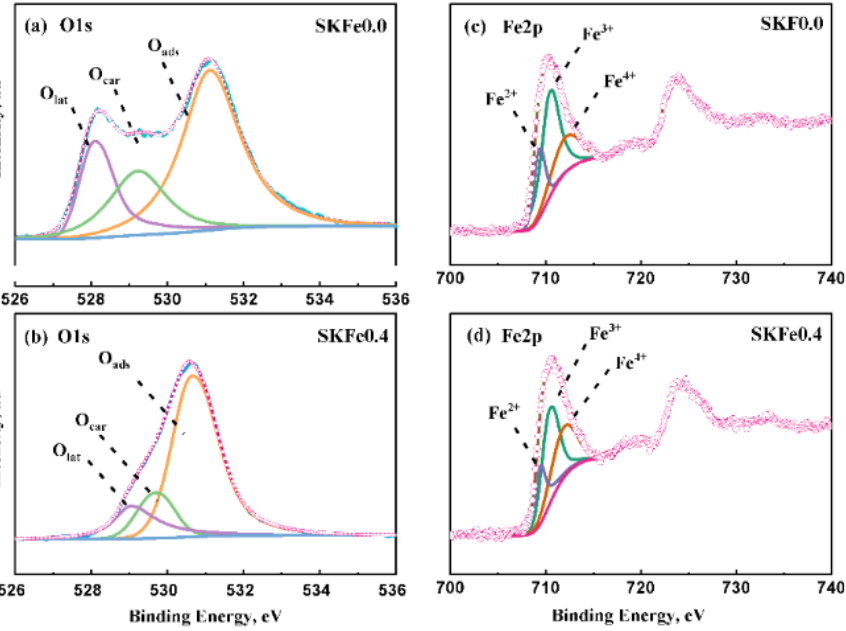
Figure 9. O 1s and Fe 2p XPS spectra and deconvolution of fresh samples: ( a , c ) SKF0.0; ( b , d ) SKF0.4. Table 1. Percentage of O1s and Fe2p3/2 of fresh